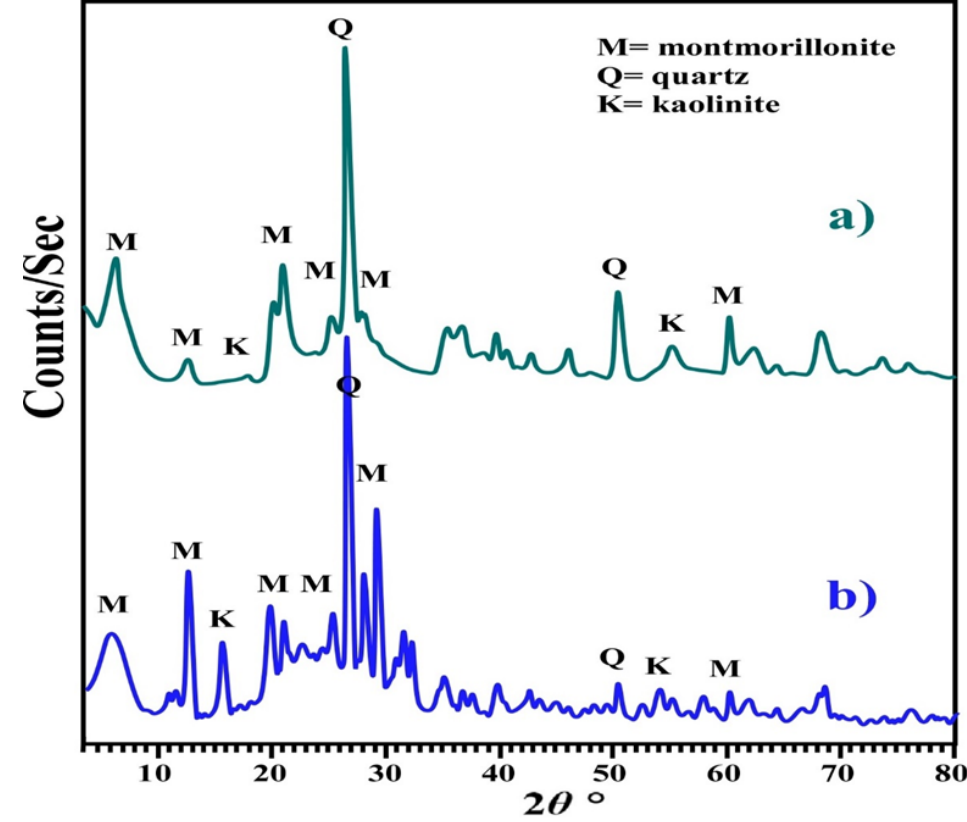
Figure 5. XRD spectra of ( a ) treated bleaching clay and ( b ) AHIBC.